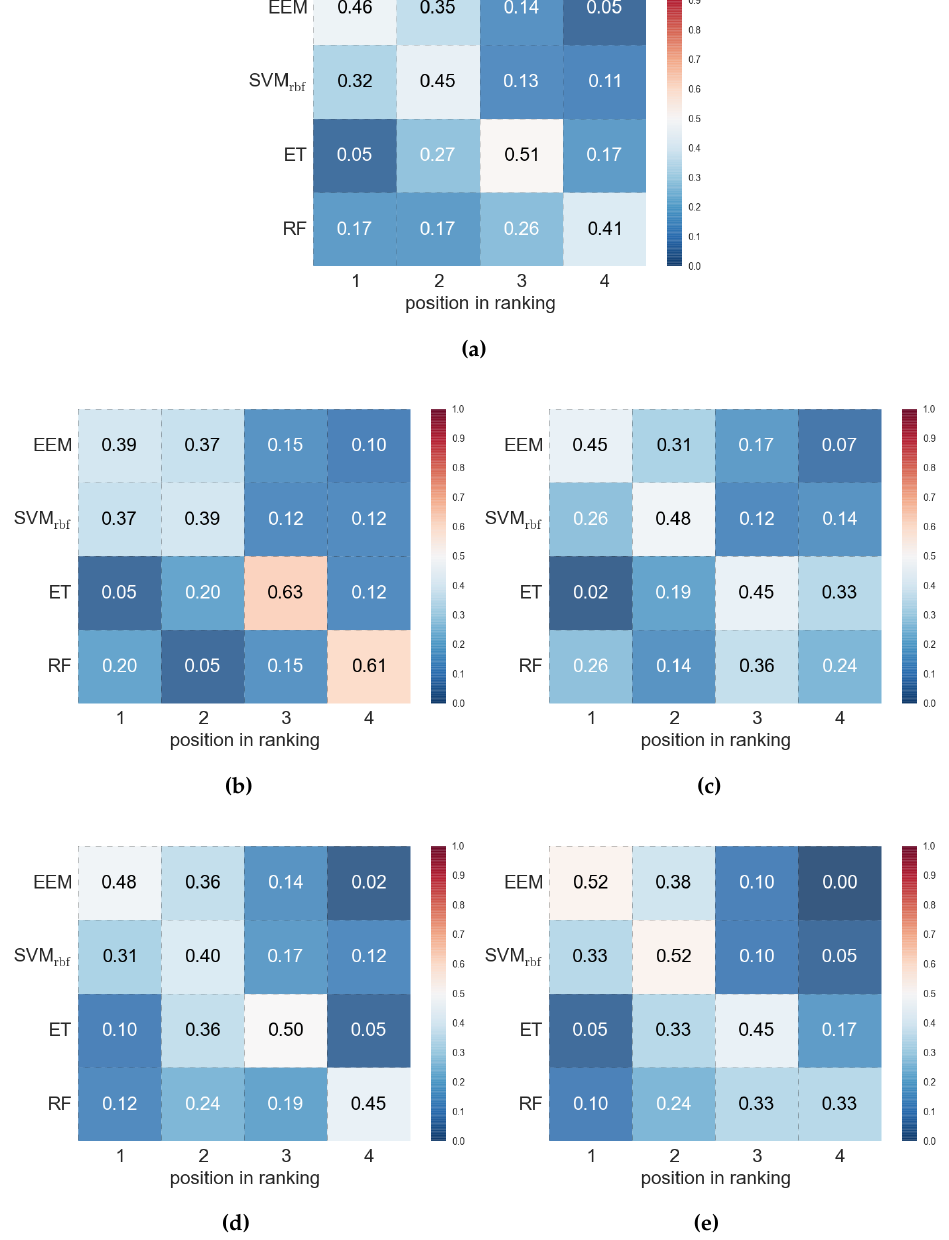
Figure 2. Heat maps that visualize the probability of a given method being at a particular position in ranking: ( a ) All experiments together; ( b ) actives/true inactives dataset; ( c ) actives/true inactives + DUDs dataset; ( d ) actives/DUD 1 dataset; ( e ) actives/DUD 2 dataset.